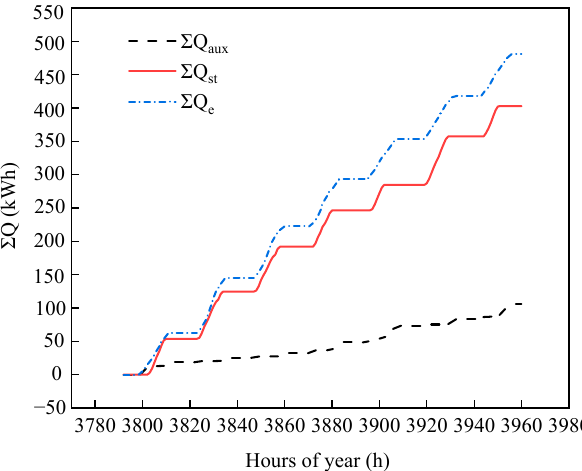
Figure 7. Variation of COP of chiller on the second day of simulation.